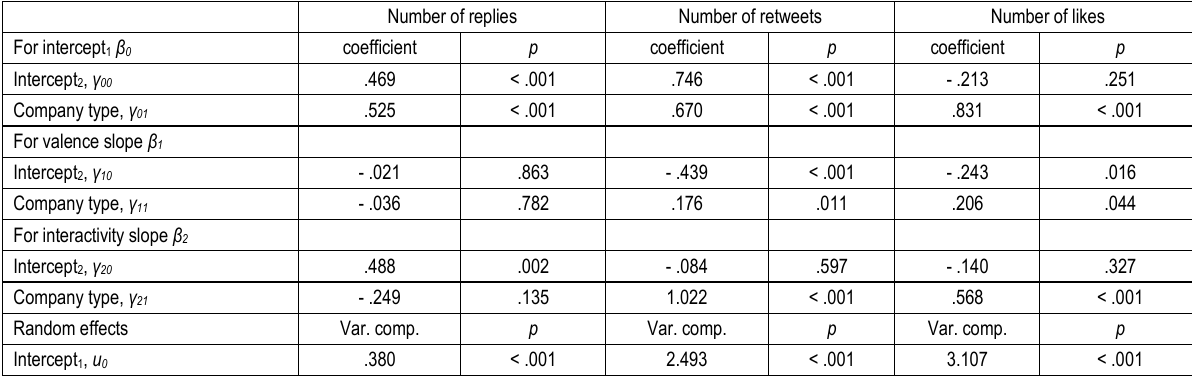
Table 1. Summary of multilevel modeling analysis